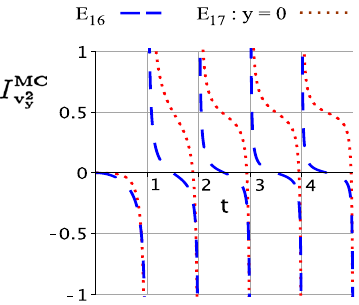
Fig. 2 Time evolution of the y -component of the orientability indi- cator I MC v in units of q 2 / m 2 for a charged test particle in Minkowski 2 y spacetime with spatial section endowed with the orientable E 16 and non-orientable E 17 topologies, both with compact length a = 1. We show curves for E 16 (dashed line) and for E 17 with the particle at P 0 = ( x , 0 , z ) (dotted line). The indicator curves exhibit similar peri- odic patterns for time intervals of the order of one, but it is possible to distinguish the two topologies by contrasting the y -component of their orientability